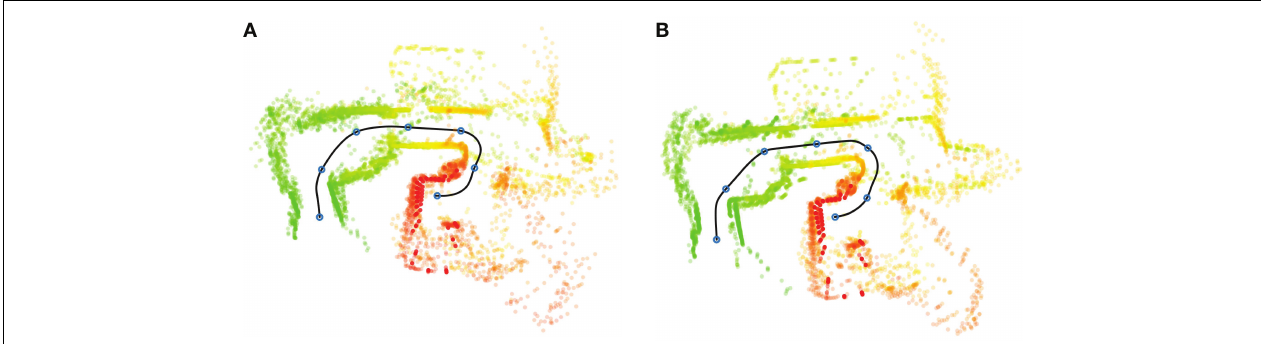
FIGURE 5 | Illustration of sensory–motor interactions along a path from bed (Area 5, Figure4) to the kitchen (Area 2), using overt (A) and covert (B) action . An approximate path is generated from executed actions and illustrated as a black line. Colored points represent laser scans in relation to the executed path, from start (green) to goal (red). This path was not presented during training and corresponds to the A to D path in Figure 2 , i.e., a novel path generated through the recombination of previously experienced episodes. Blue circles along the path mark 2.5-s intervals.